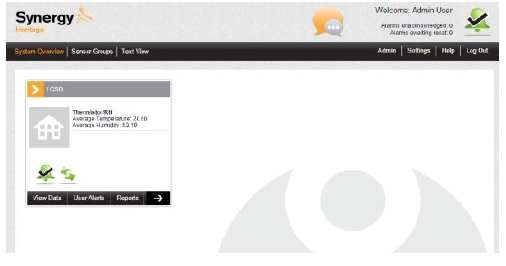
usage by introducing different levels of rights for different user groups. The administration users have the authority to grant access right to the system maintenance group and the guests group. There are various levels of application and usage for different group of